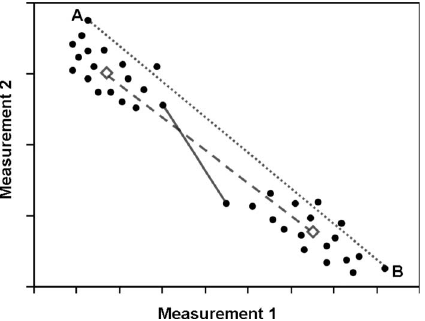
FIG. 9. Euclidian distance as a measure of similarity. The dotted line connects the farthest apart points of two clusters (cid:1) complete linkage (cid:2) . The solid line connects the closest points of two clusters (cid:1) single linkage (cid:2) . The dashed line connects the centroids (cid:1) diamonds (cid:2) of two clusters. The average linkage is not shown, as it is a math- ematical average of all pairwise distances between two clusters.